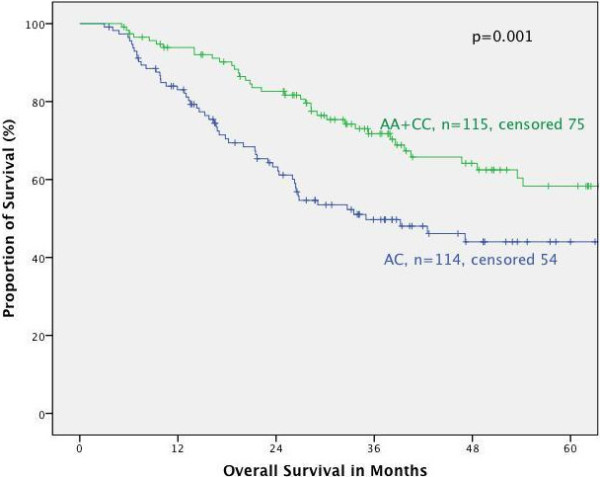
Survival in gastric cancer patients according to UICC 6th edition, MTHFR A1298C AC versus AA/CC. Legend: Subgroup analysis for patients with adenocarcinoma of the esophagogastric junction type II, III and stomach dependent on polymorphisms of MTHFR A1298C, comparing AC genoytpe to AA and CC genotype. Median Survival times: AA/CC 82.7 months, AC 35.0 months, p = 0.001).